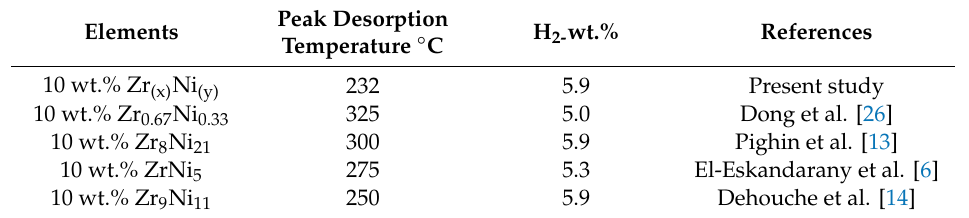
Table 3. Dehydrogenation properties of various ball milled MgH 2 nanocomposites in comparison to the results obtained in the present study. Peak Desorption Elements H 2- Temperature ◦ C